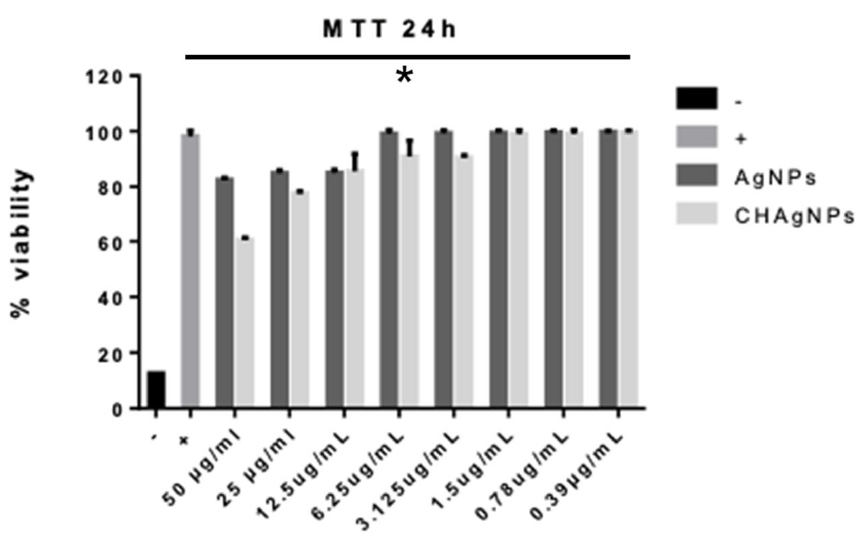
Figure 6. MTT assay on Vero cells treated with different concentrations of AgNPs and CH-AgNPs for 24 h.—refers to the negative control, i.d. cells treated with DMSO; + indicates positive control that corresponds to cells not treated with any compound. * p < 0.05.